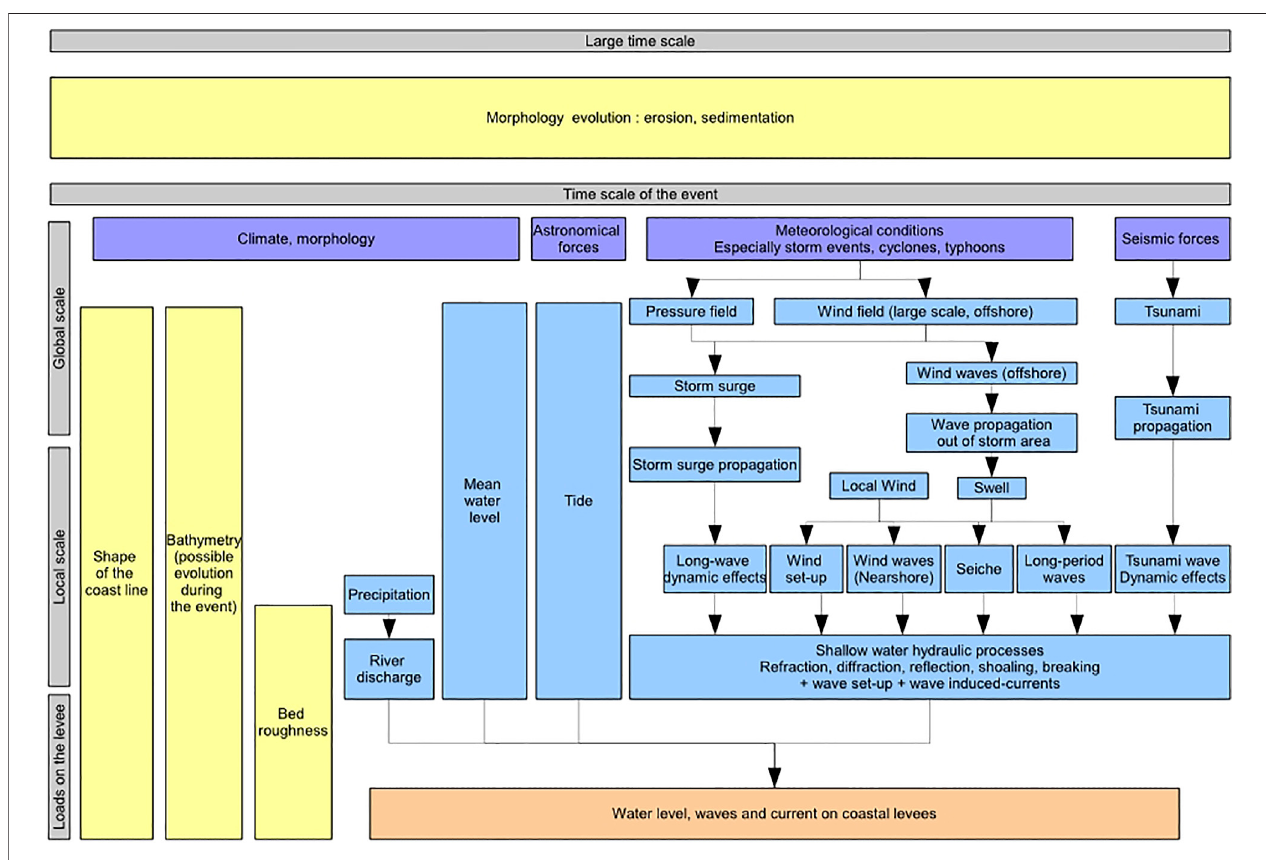
FIGURE 6 | The process of hydraulic load generation (CIRIA MEDDE USACE, 2013) — Credit: Marc Igigabel.